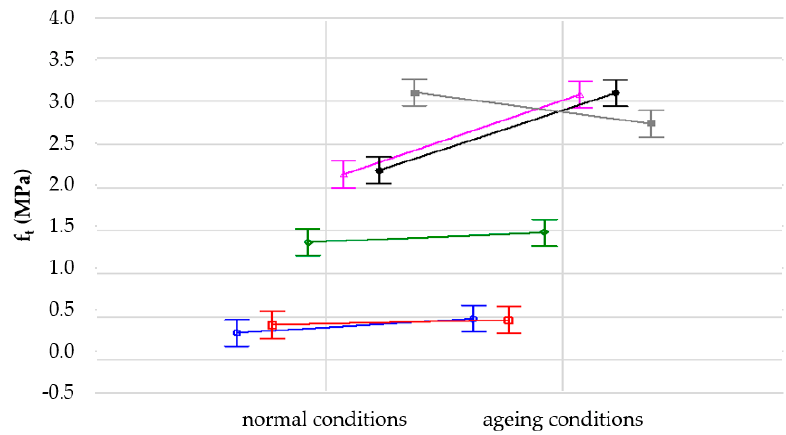
Figure 12. Influence of conditioning on tensile strength of the analyzed elastomeric materials with various densities: blue line—SBR 650, red line—SBR 700, green line—SBR 850, purple line—SBR 1000, black line—SBR 1050, grey line—SBR 1100.